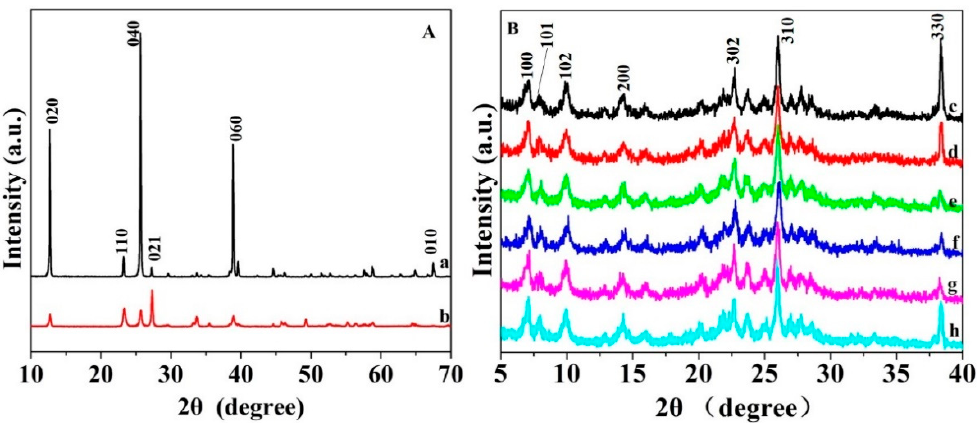
Figure 4. XRD patterns in ( A ): ( a ) MoO 3 (C) and ( b ) MoO 3 (N) and ( B ): ( c ) HMCM-49, ( d ) 2Mo(N)-HMCM-49, ( e ) 4Mo(N)-HMCM-49, ( f ) 6Mo(N)-HMCM-49, ( g ) 8Mo(N)-HMCM-49, and ( h ) 6Mo(C)-HMCM-49.